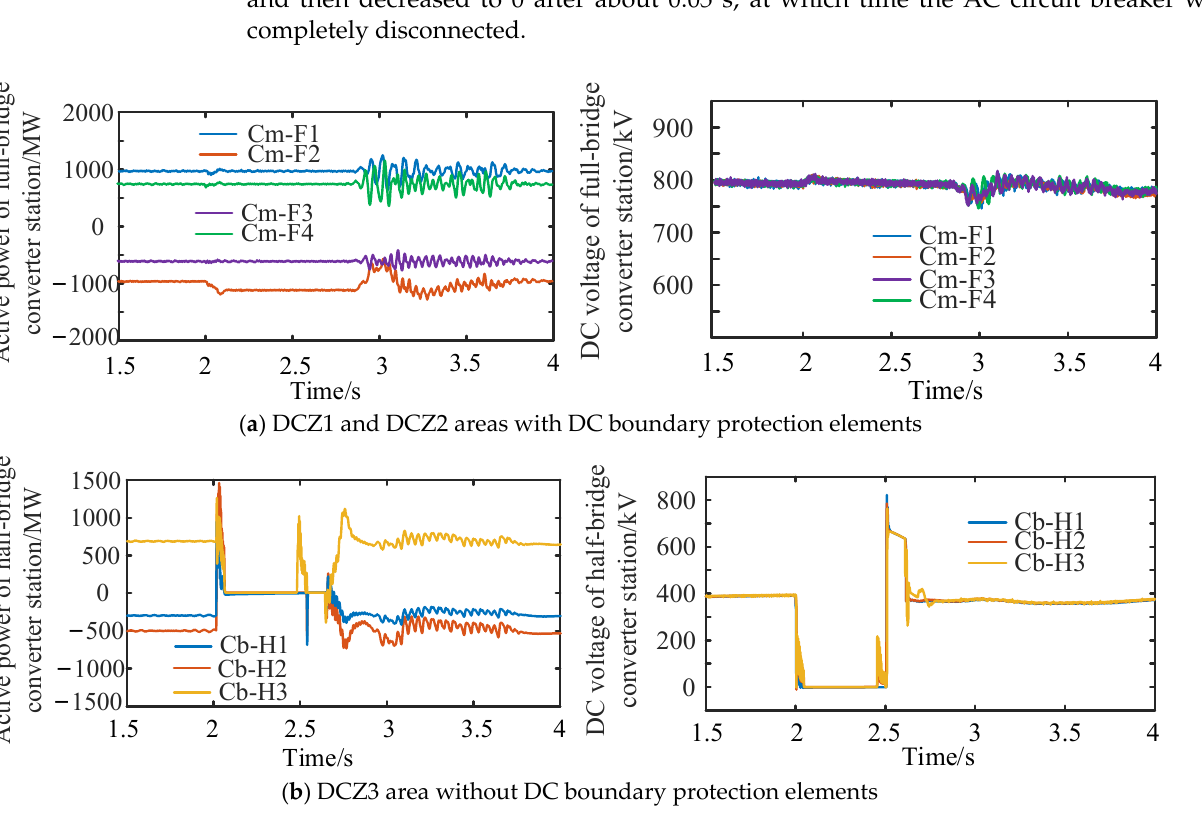
quickly recover to stable operation after internal adjustment.